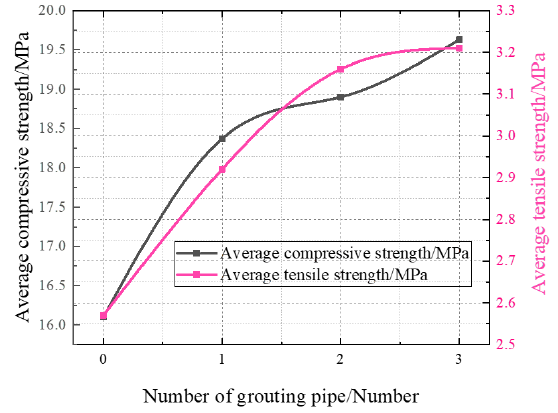
Figure 6. Influence of grouting pipe quantity on specimen tensile and compressive strength.